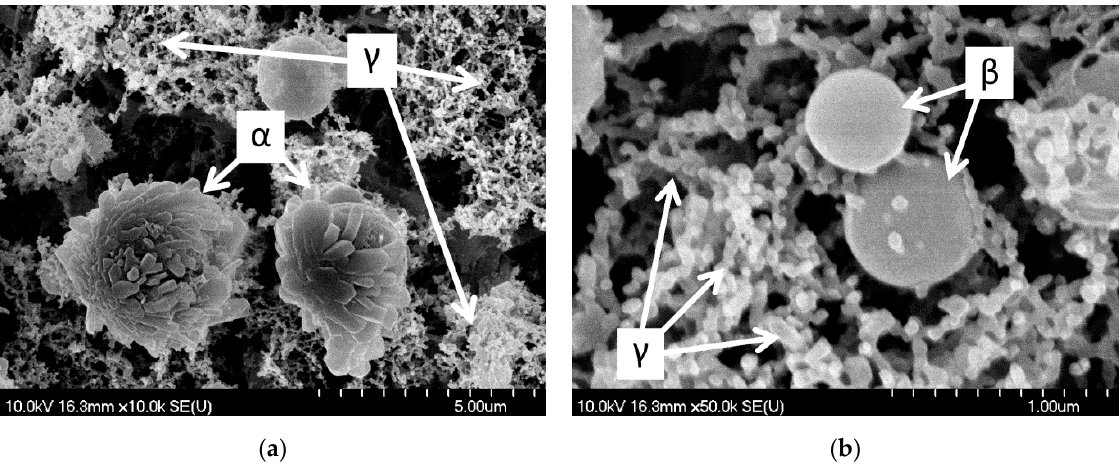
Figure 6. SEM pictures of PLA-generated particles (at 1.5 J/cm 2 fluence) collected on the filter: (α) spheres with an irregular surface covered by laminar blocks; (β) perfectly smooth spheres and (γ) small (~0.1 µm in diameter) spherical particles joined into chains, creating a web-like structure. ( a ) M: 10k; ( b ) M: 50k.